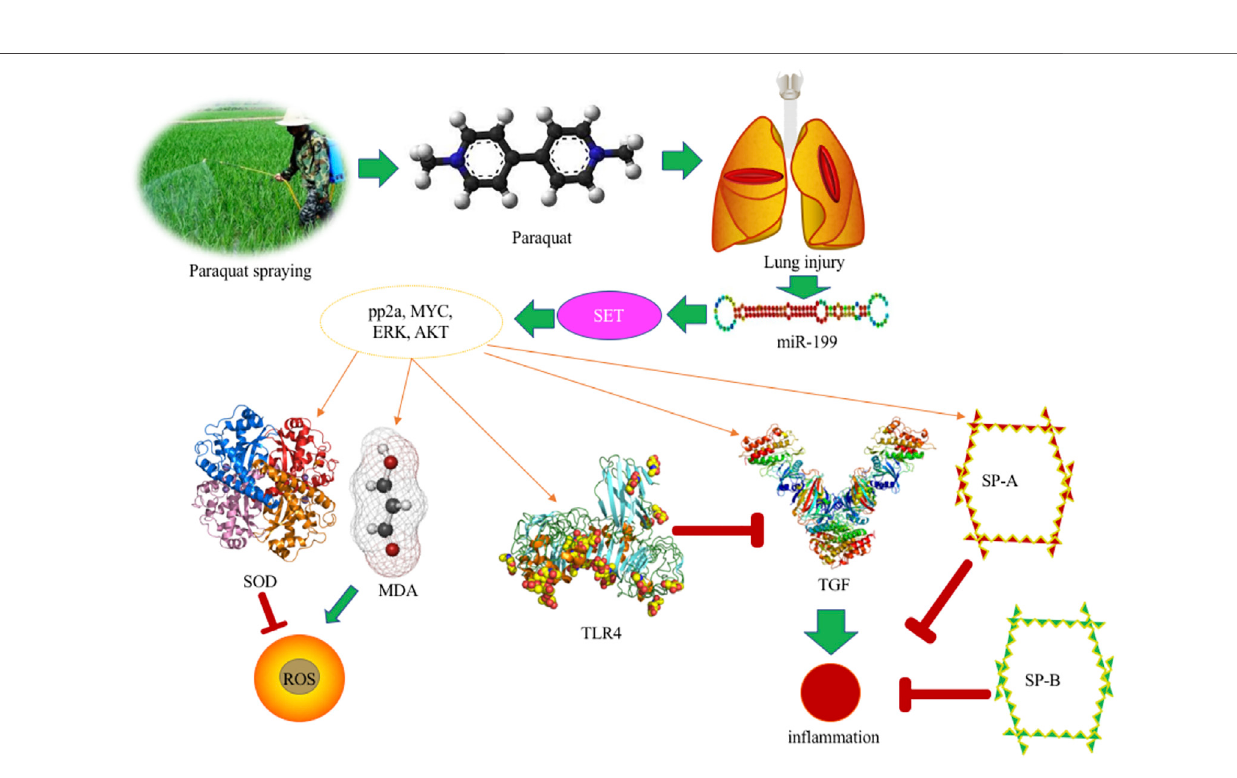
Frontiers in Pharmacology |